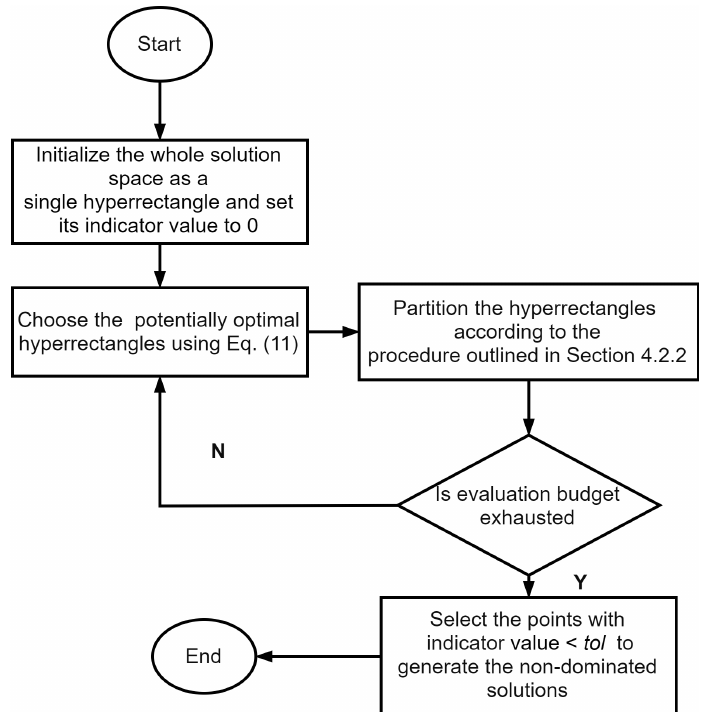
Figure 3. Procedure of multiDecompose